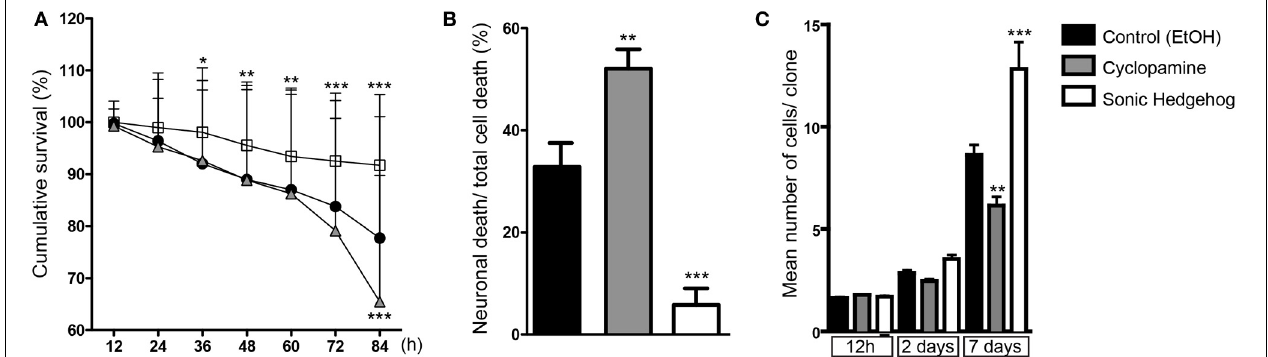
FIGURE 8 | SHH improves survival of cortical cells. (A) Cumulative cell survival of cortical cells in cultures treated with cyclopamine (gray triangles), SHH (white squares), and control (black circles). Note that SHH increases cell survival at early time-points, whereas cyclopamine decreases cell survival at 84h. ∗ p < 0 . 05, ∗∗ p < 0 . 01, ∗∗∗ p < 0 . 001 (row factor), Two-Way ANOVA followed by Bonferroni post-hoc test, number of clones analyzed, control: 137,